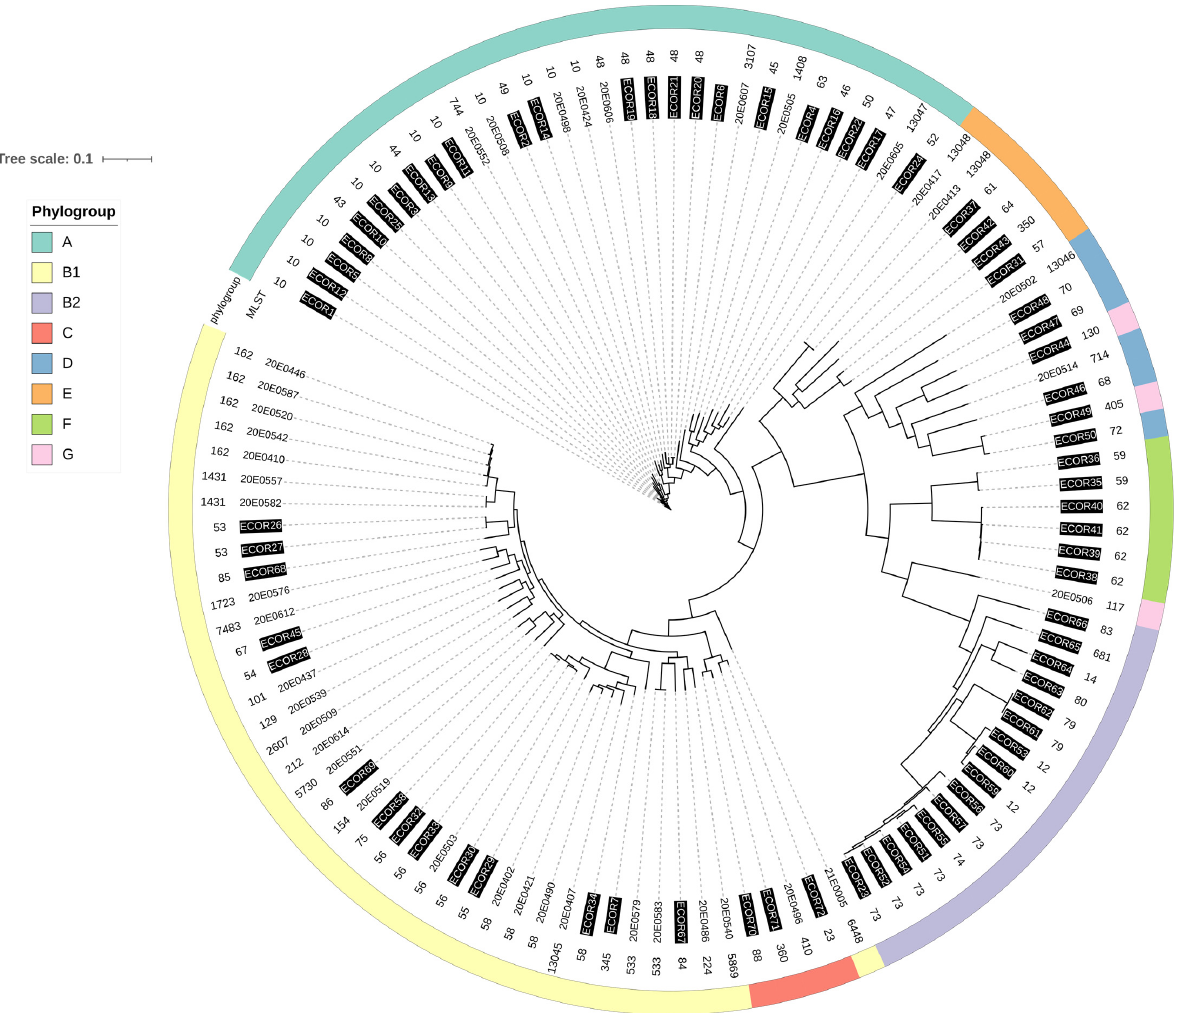
Figure 2. Whole-genome sequencing tree with the 39 E. coli strains from SAC and 72 ECOR strains (inverse print) in the innermost ring. The middle ring indicates multi-locus sequence typing (MLST) assignments; the outermost ring indicates the phylogroups in different colors. The image was generated with ITOL (v.6)).